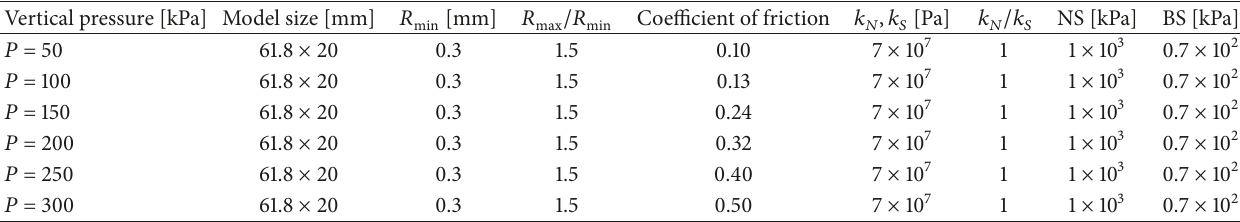
Table 3: Calibrated values of the main microparameters at different vertical stresses.